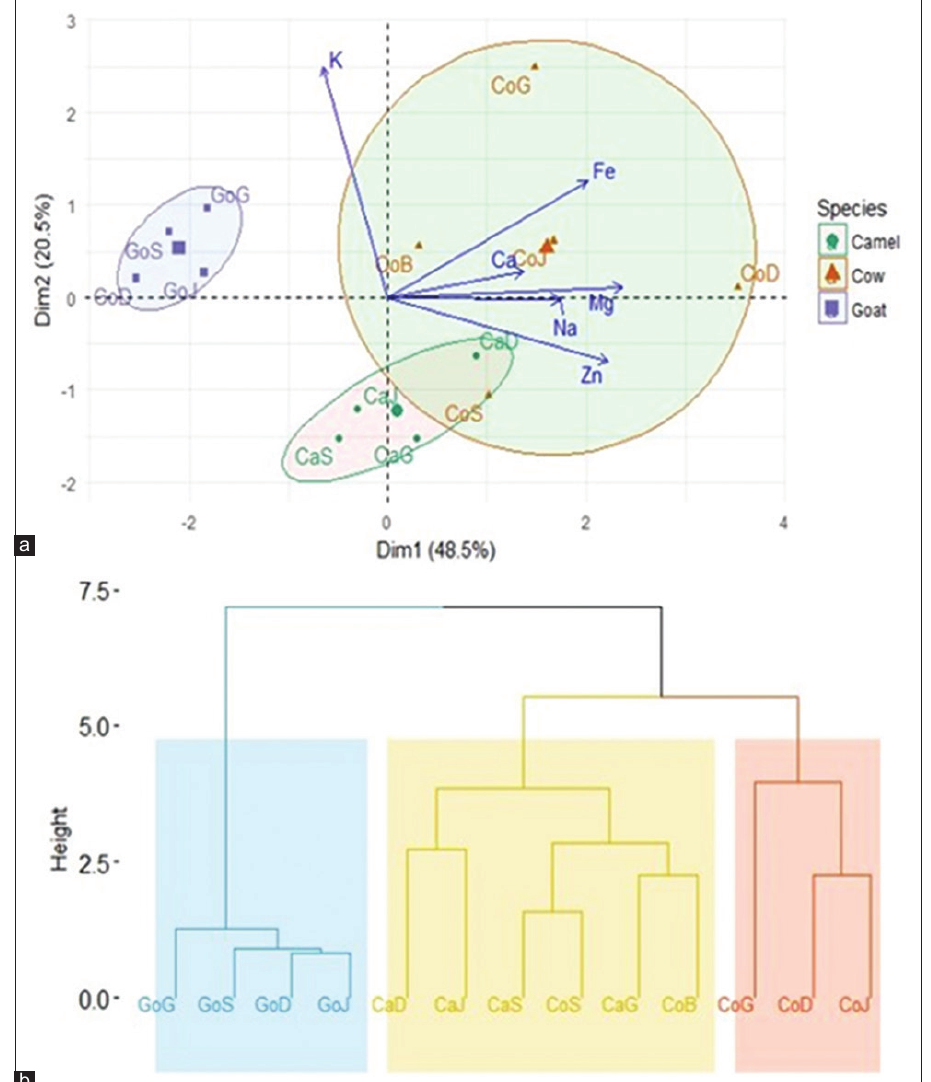
Figure-4: Principal component analysis distribution of fermented milk samples and ellipse of inertia different species on the factorial plane according to minerals concentration (a); ascending hierarchical clusters according to minerals concentration of fermented milk from different species